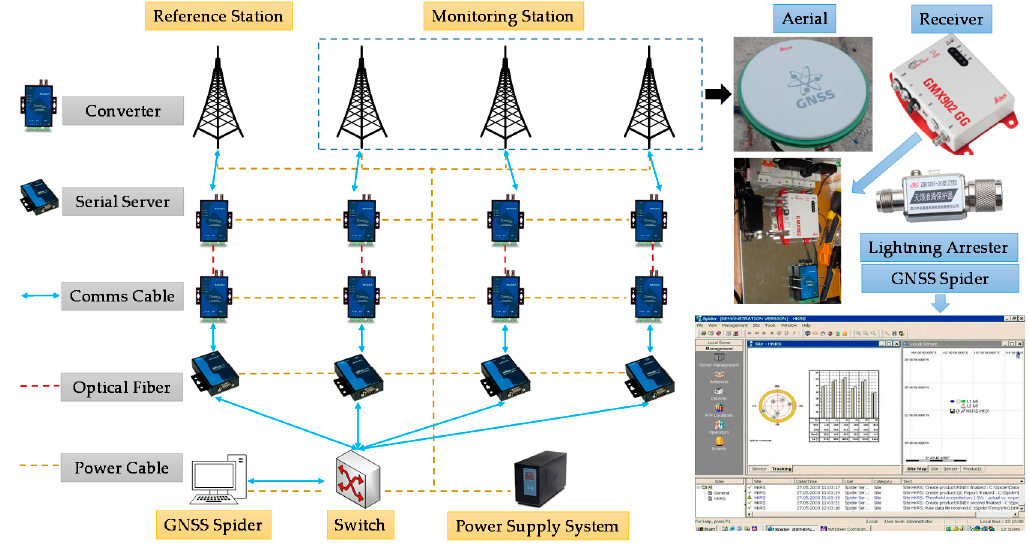
Figure 4. GNSS deformation monitoring system.